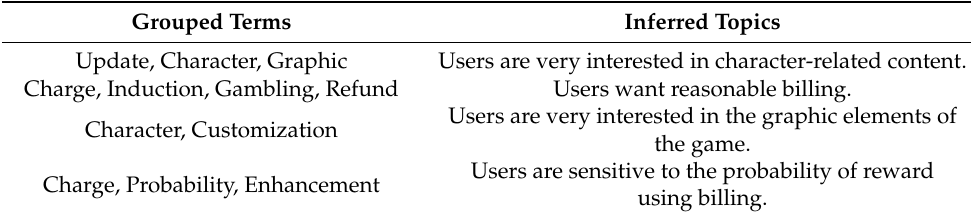
Table 2. Grouped terms and inferred topics.